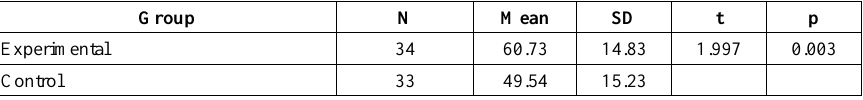
Table 8. Descriptive and t-test findings related to time spent online. Group N Mean SD t p